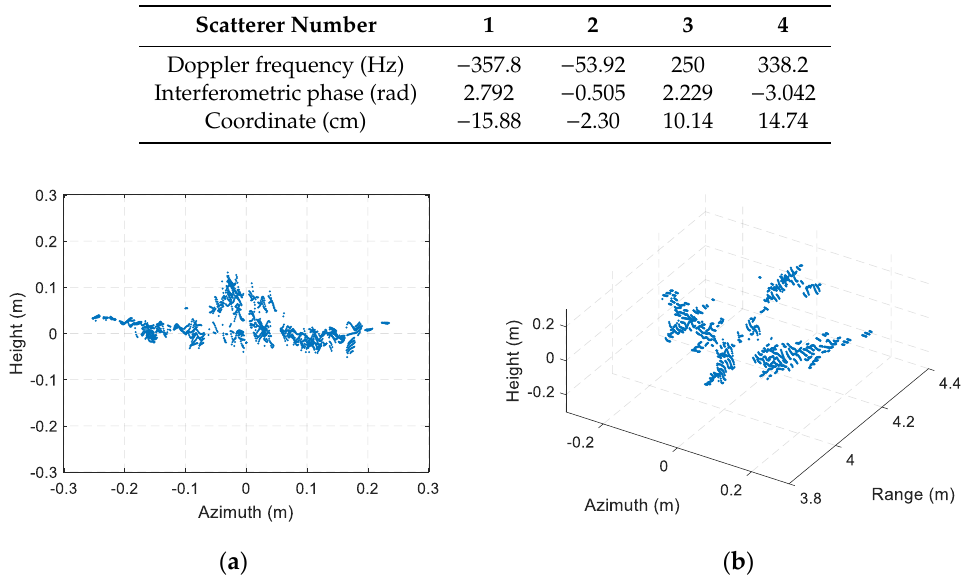
Figure 11. InISAR imaging results of A380 model with small rotation angle. ( a ) Front view; ( b ) Three-dimensional view. Table 2. Doppler frequencies and coordinates of four dominant scatterers.